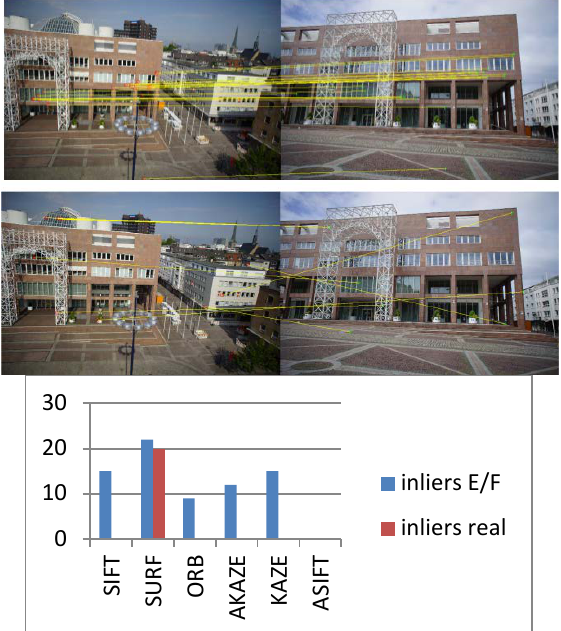
Figure 10: pair-8 results. Upper: SURF, middle: SIFT, lower: for each number of matches after E-/and F-based filtering (blue) and real inliers (red) Achieved results are poor, cf. Fig. 10: although in all cases